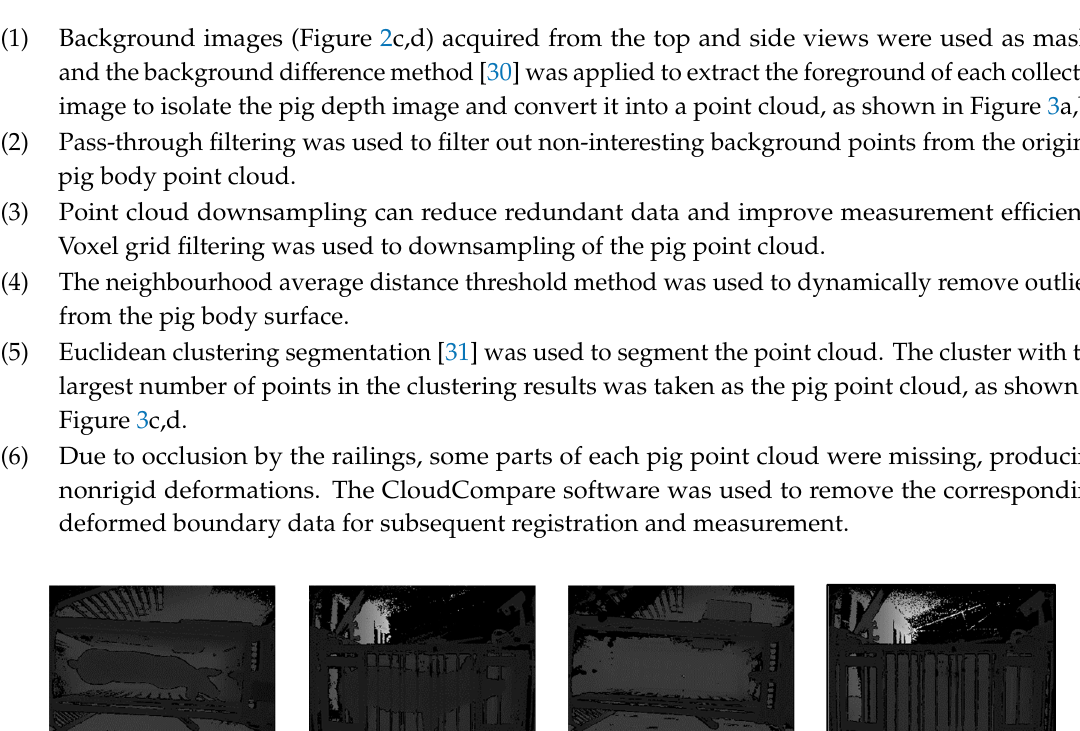
Figure 3. Pig point cloud preprocessing. In these images, the red axis is the x -axis, and the green axis is the y -axis. ( a ) and ( b ) Top- and side-view pig point clouds extracted from depth images after background difference processing; ( c ) and ( d ) Top- and side-view pig point clouds obtained after filtering and segmentation. 2.3. Registration Two-View Pig Point Clouds with Feature-Based Improved 4PCS Method